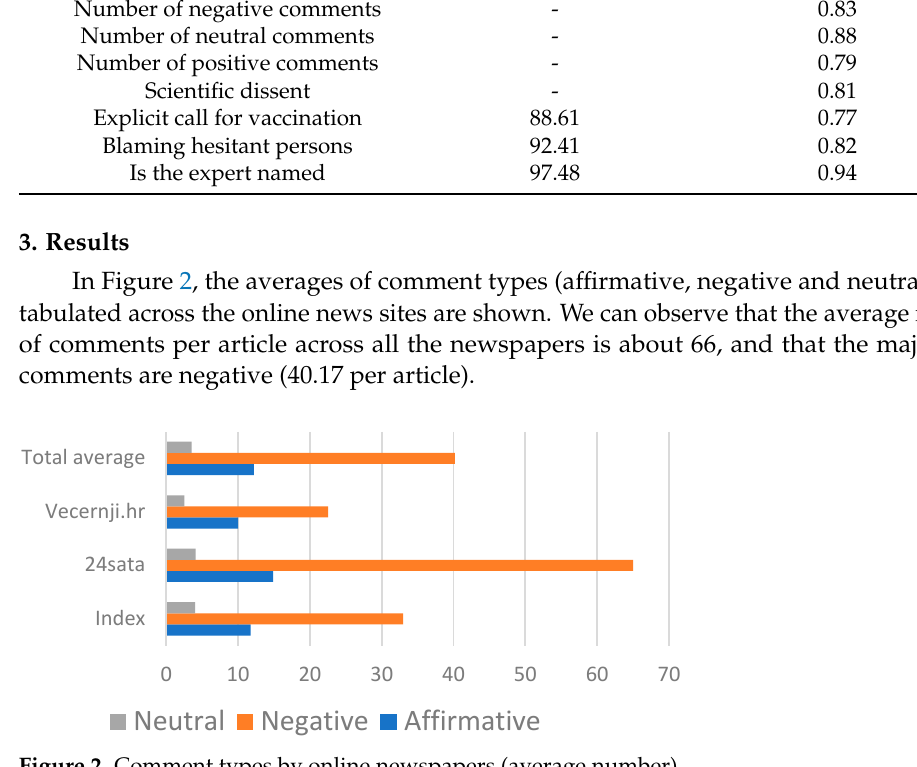
Figure 2. Comment types by online newspapers (average number).